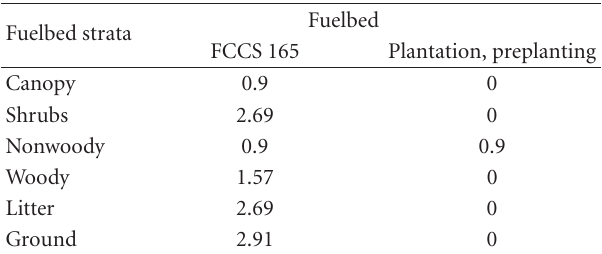
Table 1: Fuel load (Mgha − 1 ) for initial FCCS fuelbed 165 and starting point for plantation fuelbeds; fuelbed 165 is typical for a longleaf pine savanna with a herbaceous layer dominated by grasses and forbs, burned